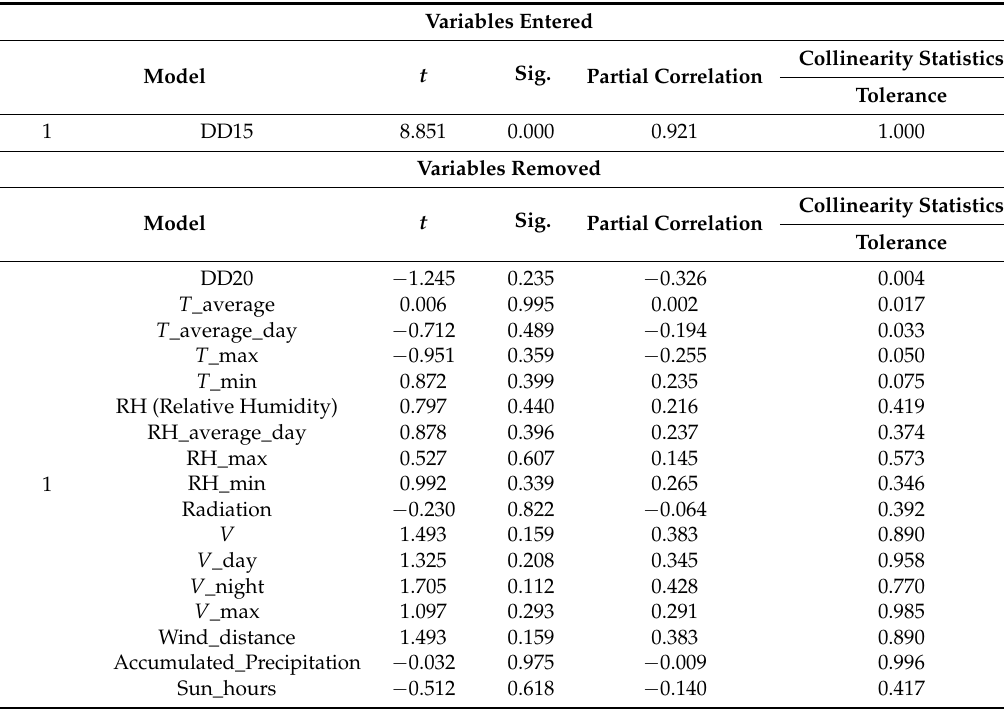
Table 2. Inputs and deleted variables in the model D3